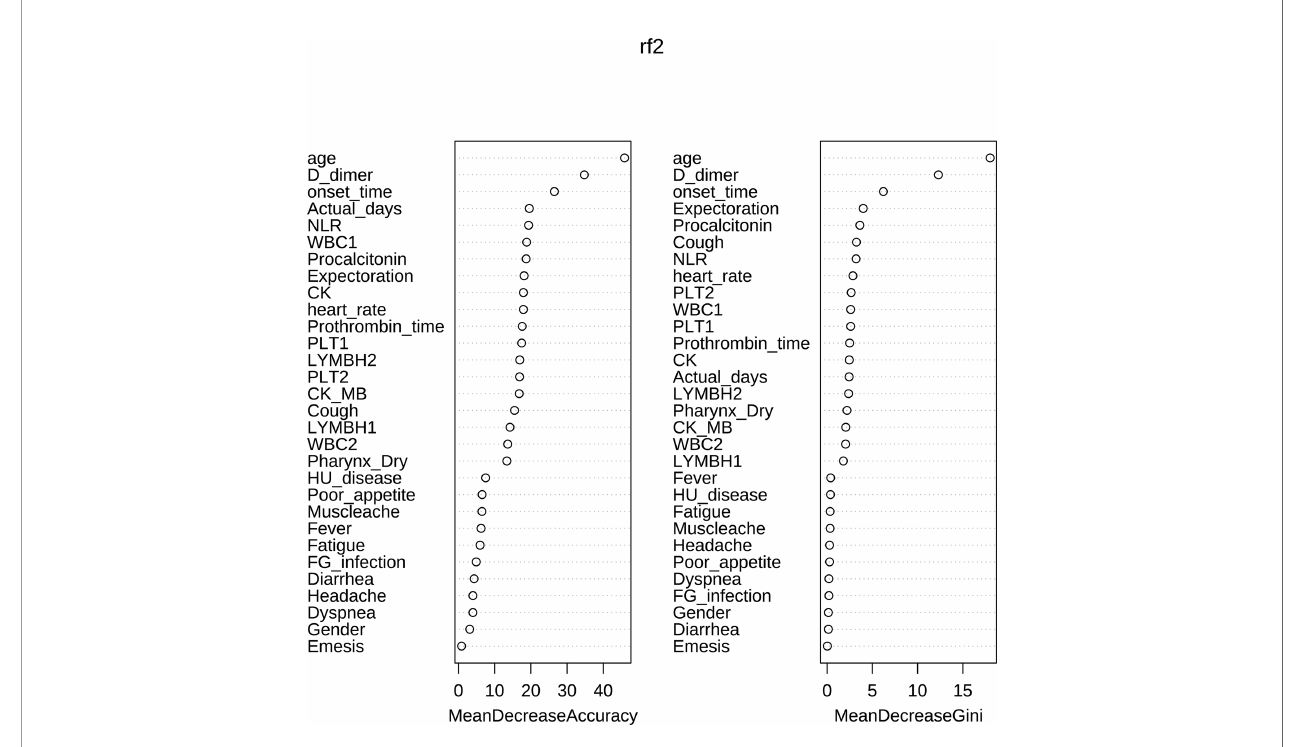
FIGURE 5 | Ranking chart of importance of